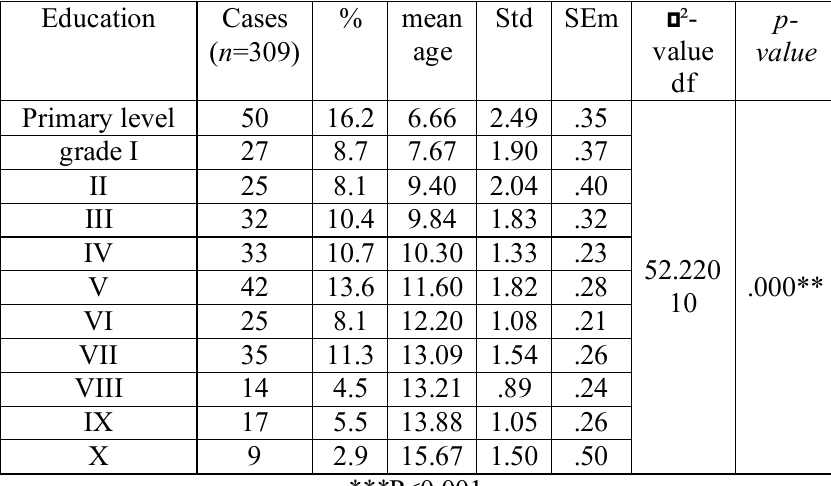
Table 3: Distribution of cases according to level of